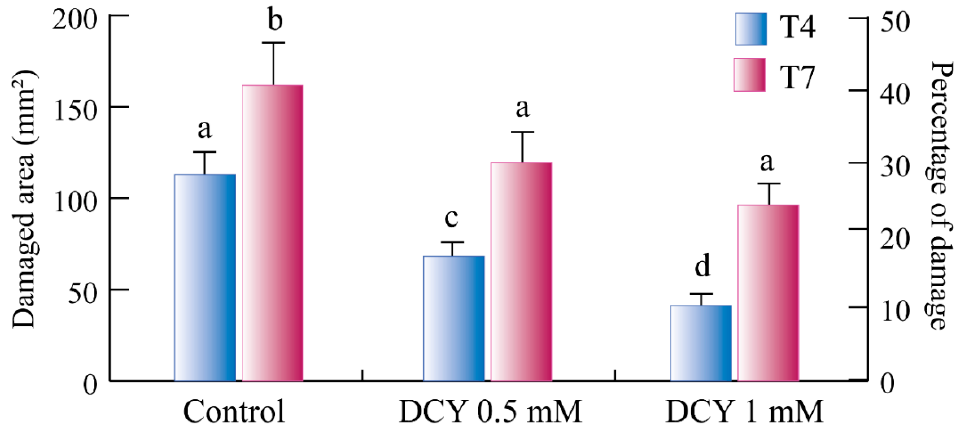
Figure 7. Effect of decoyinine (DCY) on TSSM. Bar graphs represent the amount of damage (left axis) and the percentage of damage (right axis) inflicted by TSSM on Lima bean ( Phaseolus lunatus ) leaves. Controls (without the use of DCY) and two concentrations of DCY (0.5 mM and 1 mM) were used to evaluate the amount of damage inflicted by TSSMs at 4 and 7 days (T4 and T7) after the onset of the experiment. Error bars indicate standard deviation; different letters indicate significant ( p < 0.05) differences.